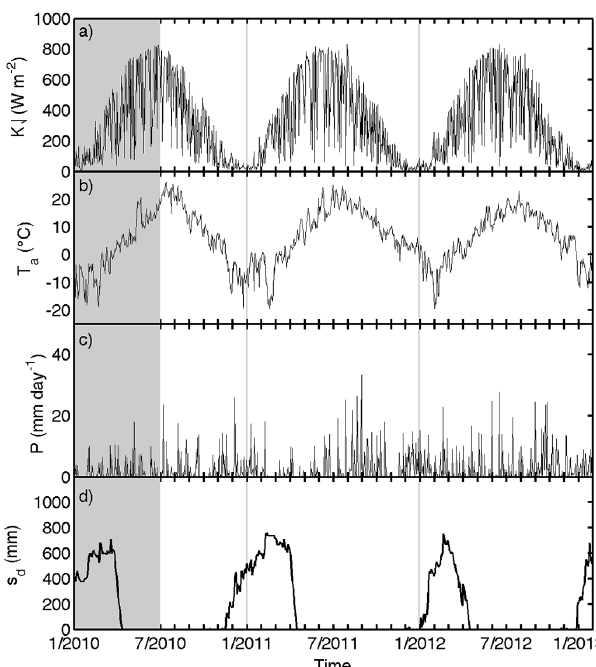
Figure 2. Time series of daily (a) daytime (10:00–14:00) solar ra- diation ( K ↓ ) , (b) air temperature ( T a ) , (c) precipitation ( P) mea- sured in SMEAR III – Kumpula, and (d) snow depth measured at Kumpula. The grey area shows the spin-up period.